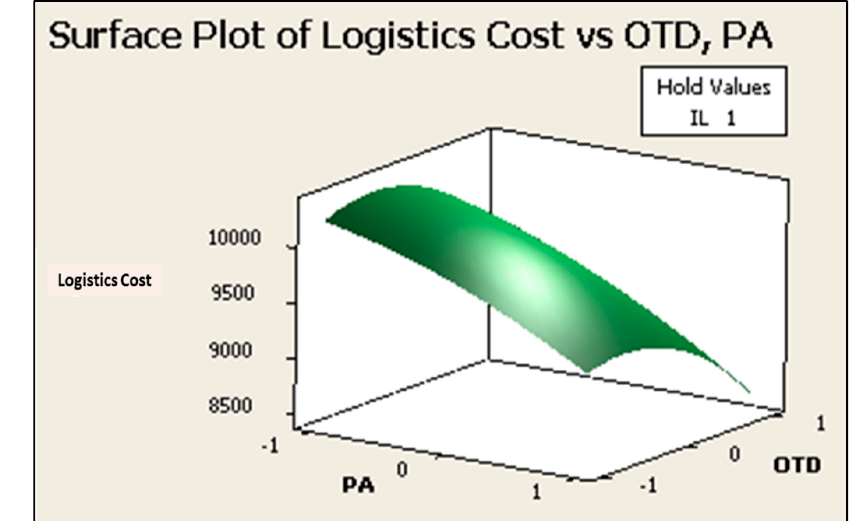
Figure 5. Surface Plot for Logistic Cost.